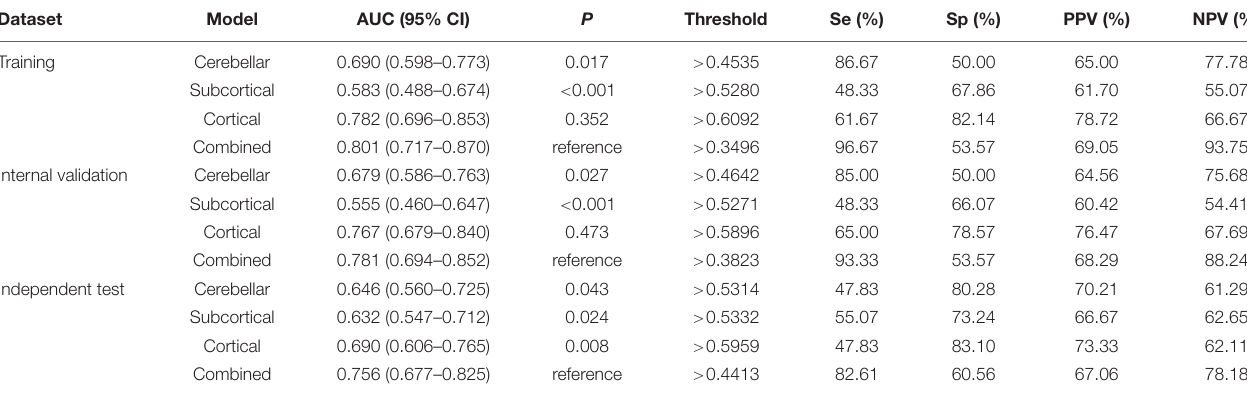
TABLE 3 | Detailed performance of the predictive models in the training, internal validation, and independent test datasets. Dataset